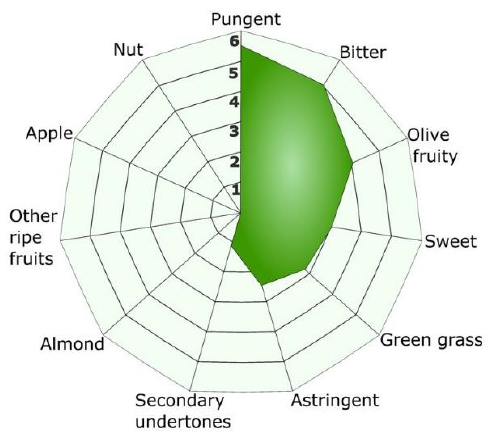
Figure 1. Sensory virgin olive oil characteristics.